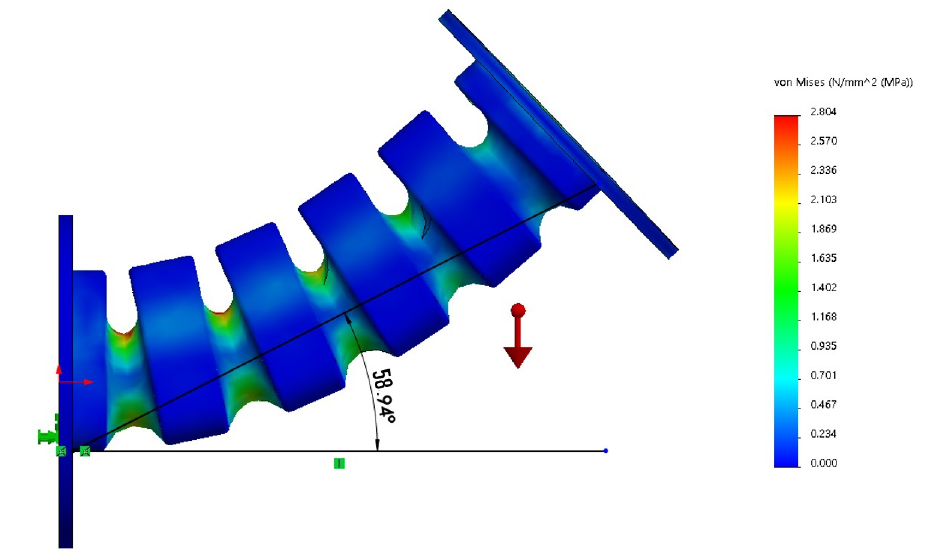
Figure 9. Simulation of soft joint with a 60 N upward force applied on the free